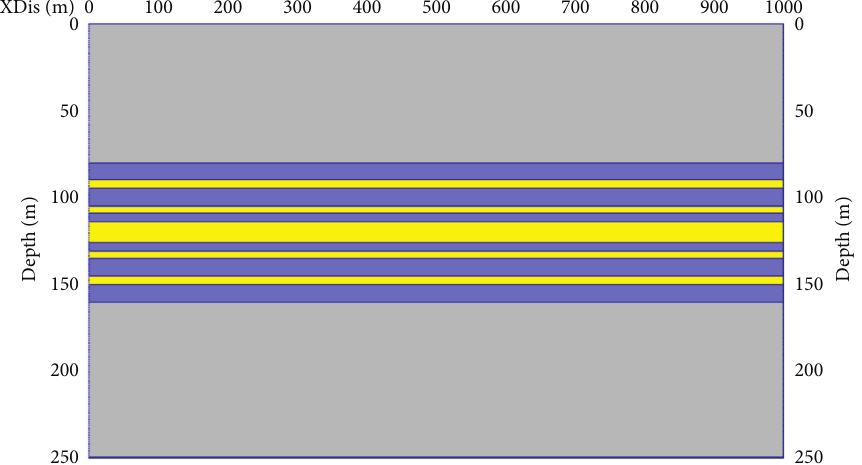
Figure 17: Geological model containing only the target layer.